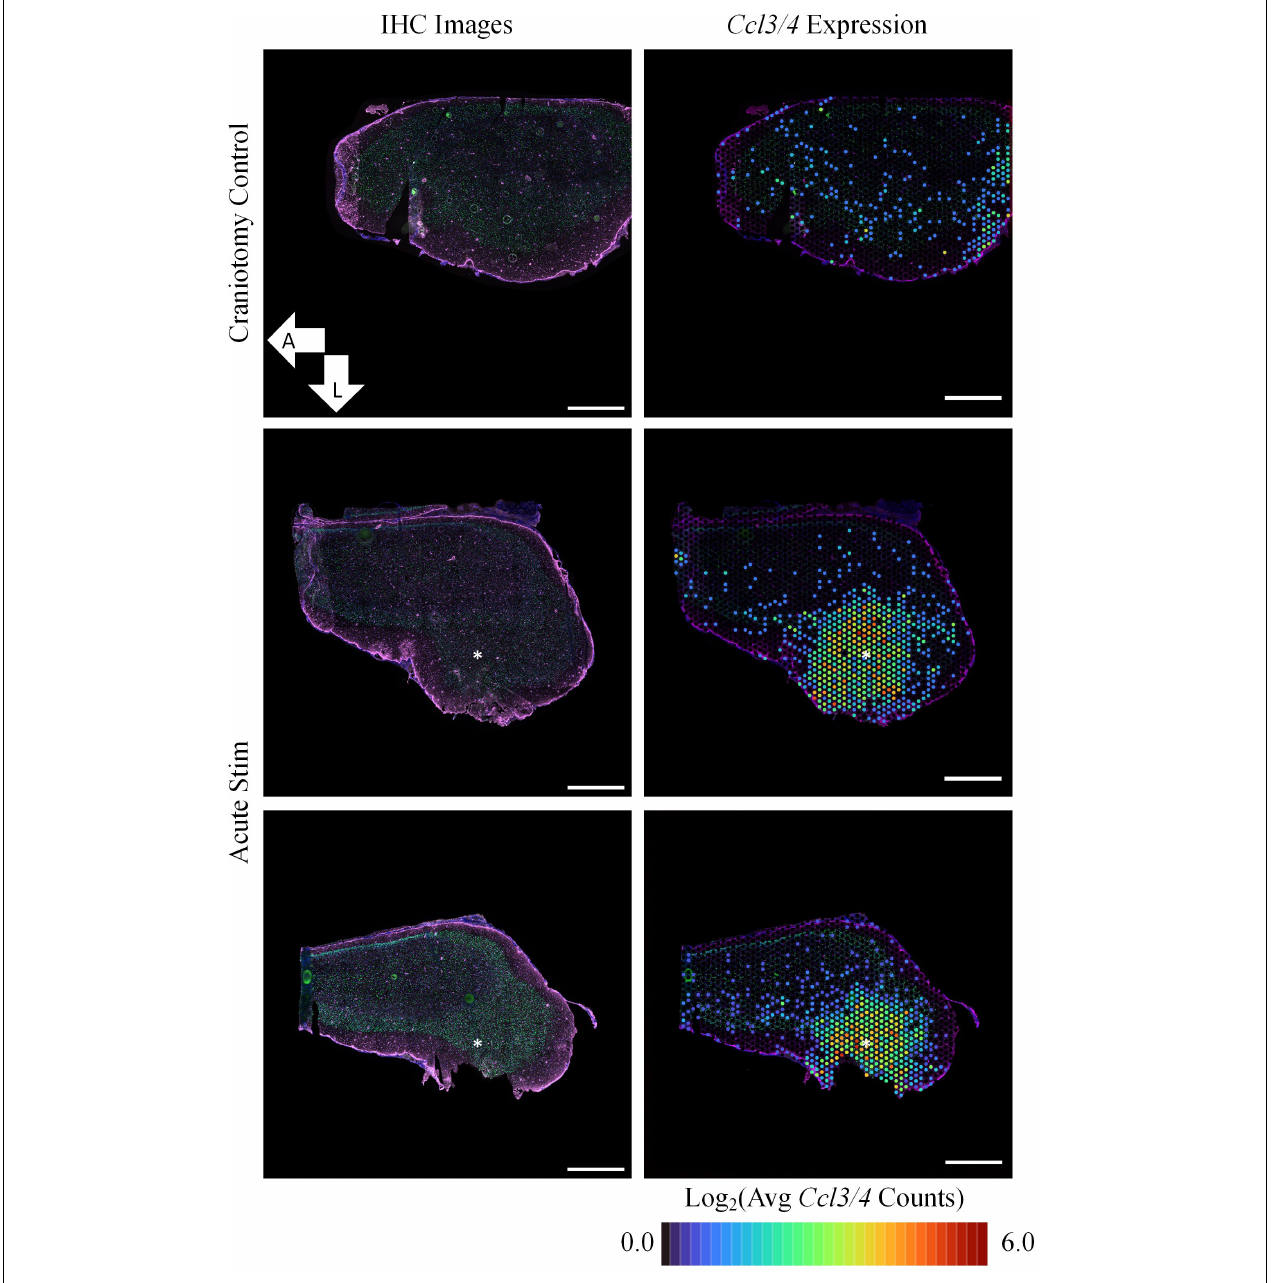
FIGURE 1 | Acute experiments show upregulation of Ccl3/4 following device implantation and stimulation. In comparison to tissue collected following a sham surgery (craniotomy only, top row), implantation of an HDCF electrode and stimulation was associated with strong upregulation of genes encoding inflammatory cytokines ( Ccl3/4 , right column). Immunohistochemistry (IHC) for astrocytes (GFAP, purple) and neuronal nuclei (NeuN, green) showed comparatively little effect on protein expression at the acute time point (nuclei are counterstained with Hoechst, blue). All images shown are transverse sections, with orientation as annotated. Right panels show the average spatial expression of Ccl3 and Ccl4 overlaid on the IHC image of each tissue section. Asterisks denote estimated implant site and arrows denote direction (L: lateral, A: anterior). Scale bars: 1.0 mm.